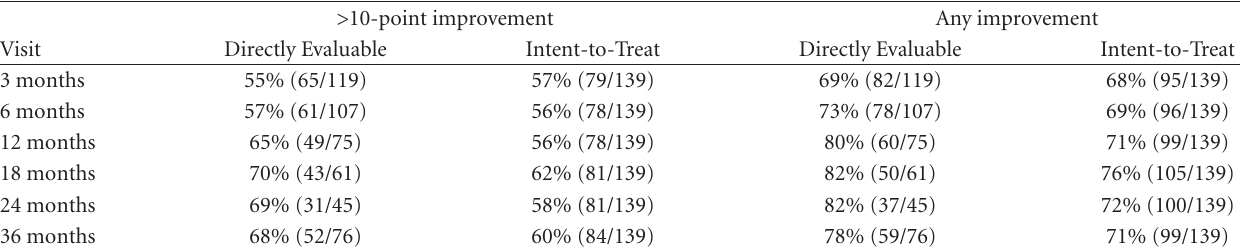
Table 5: Improvement in incontinence qualify of life questionnaire scores